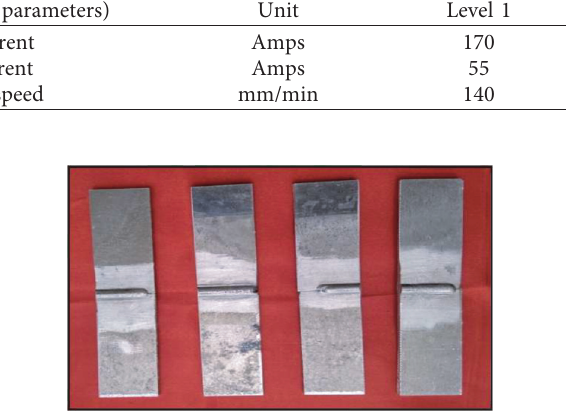
Figure 1: TIG-welded AA8006 plates.